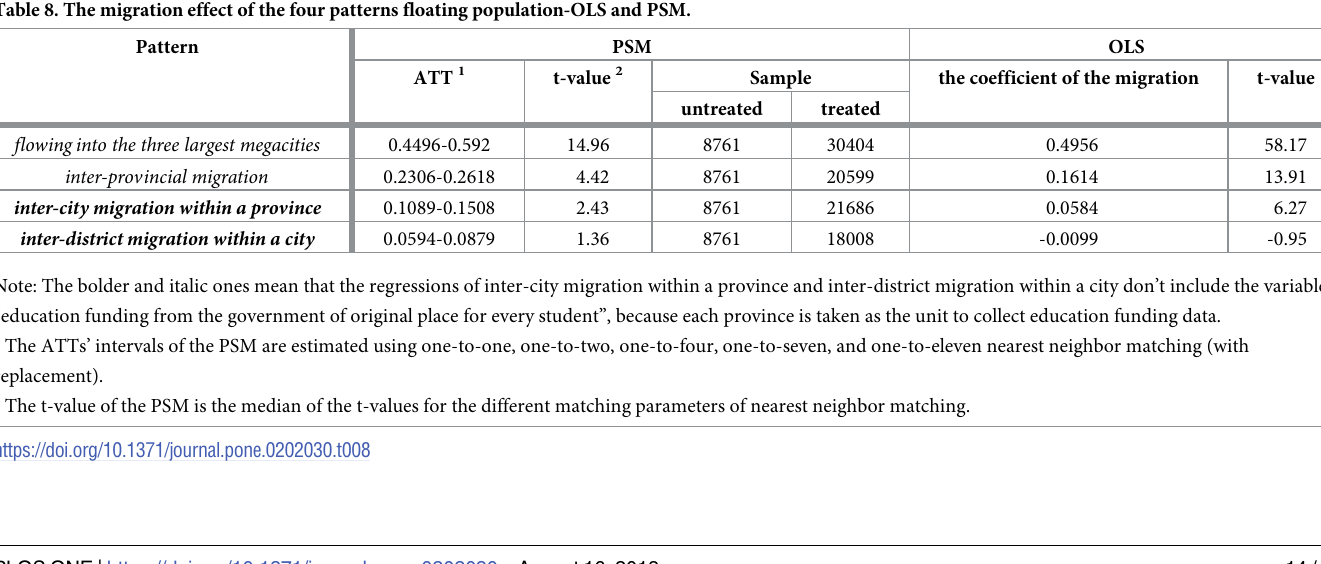
Table 8. The migration effect of the four patterns floating population-OLS and PSM. Pattern PSM OLS flowing into the three largest